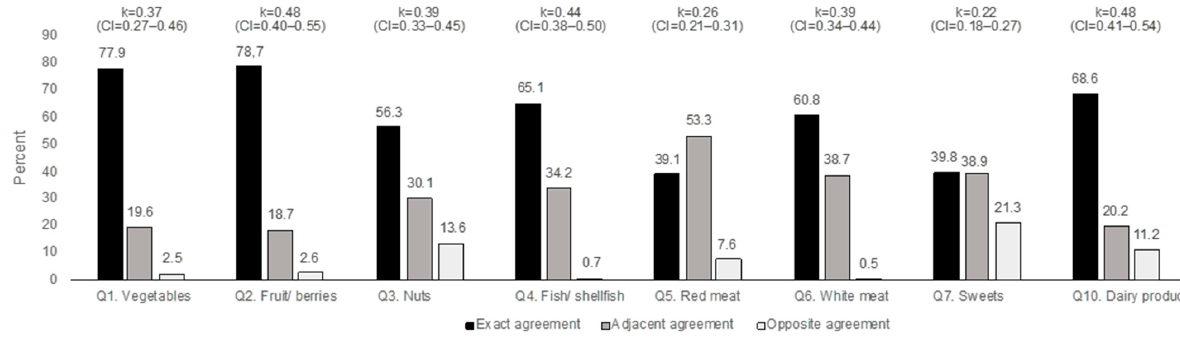
Figure 1. Proportion of agreement between methods for frequency items in the Food Frequency Questionnaire compared with Diet History, and respective weighted kappa values.